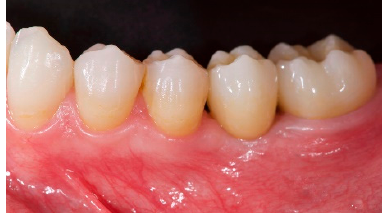
Figure 4. Implant reopening. Bone gain obtained after guided bone reconstruction.